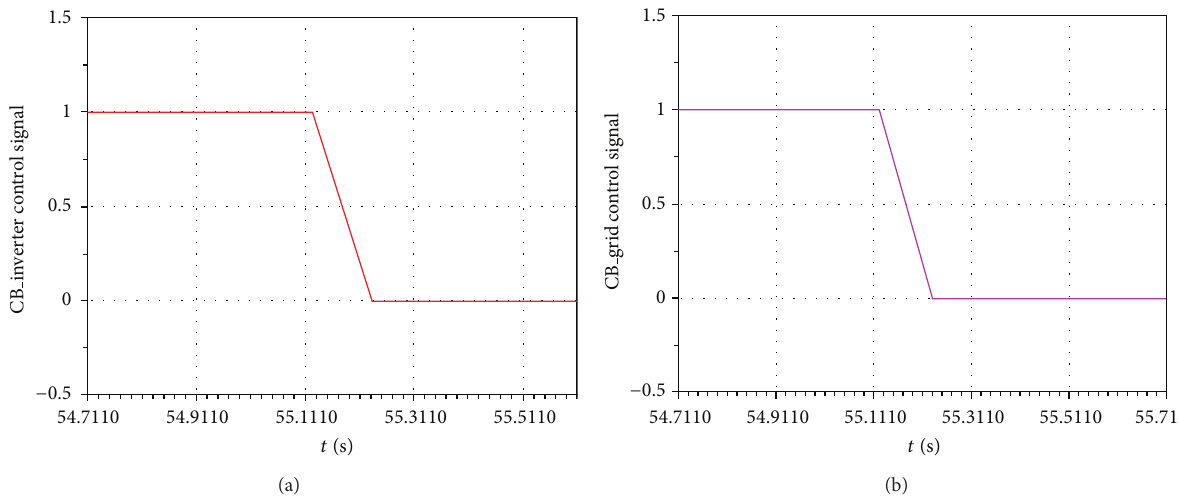
Figure 28: Control signals of circuit breakers for under voltage